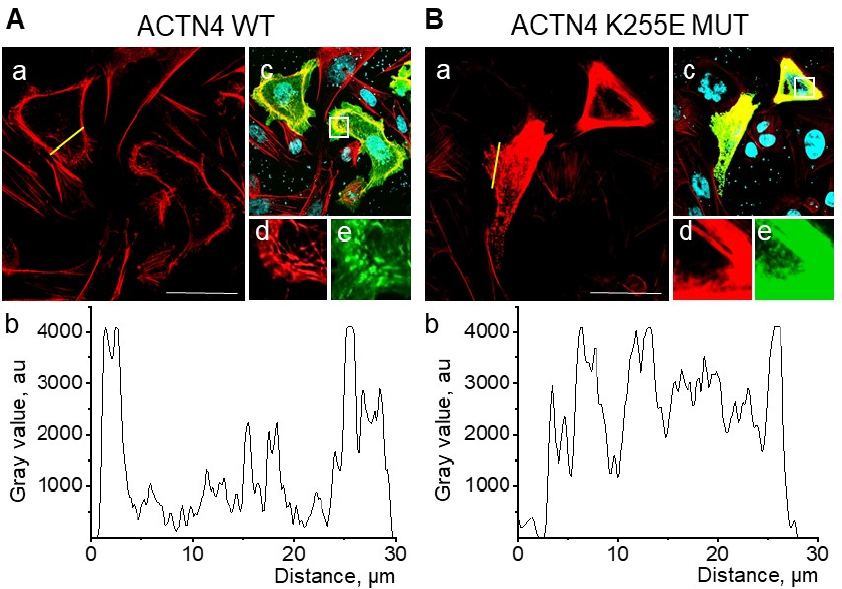
Figure 6. Effect of ACTN4 K255E mutant on actin cytoskeleton arrangement. CHO cells were transiently transfected with plasmids encoding wild type ( A ) or mutant K255E ACTN4 ( B ). Scale bar is 50 µ m. a—rhodamine-phalloidine emission (red); b—histogram of relative fluorescence across a region of interest (yellow line); c—merged image of rhodamine-phalloidine (red), GFP-labeled α -actinin-4 (green) and Hoechst-33342 (nuclei, blue) emissions. Panels (d) and (e) are zoomed areas from panel (c) (marked by white square), for rhodamine-phalloidine and GFP-labeled α -actinin-4, respectively.